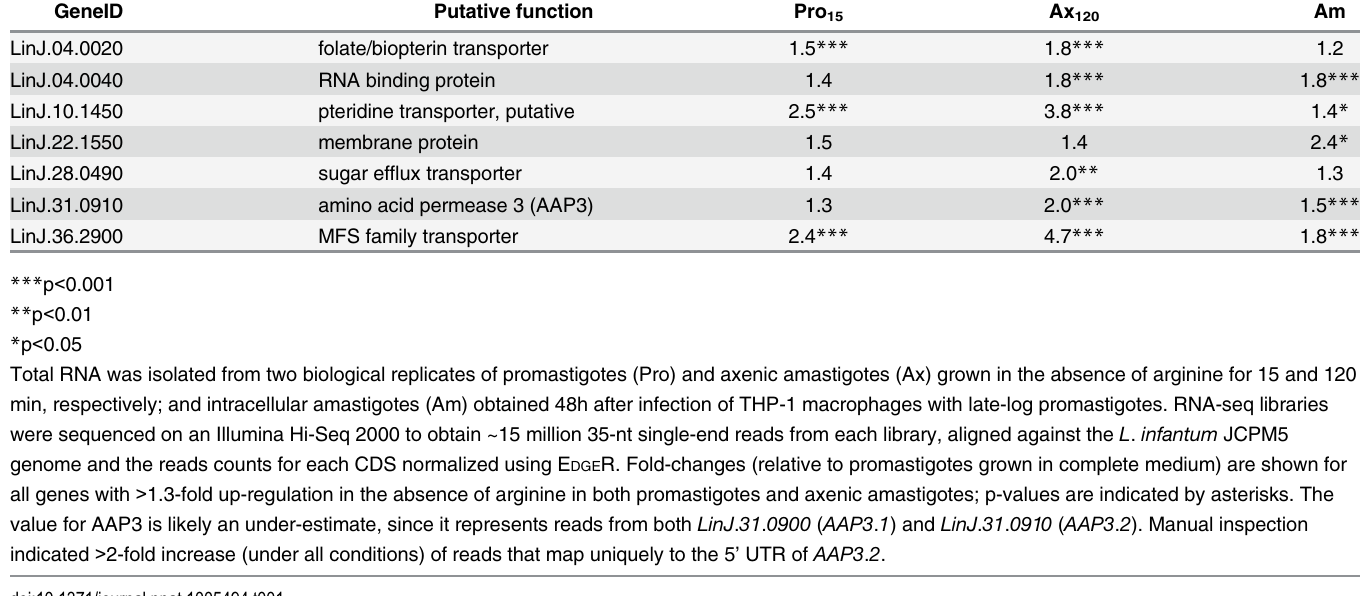
As indicated above, Leishmania cells sense changes in the external arginine concentration. To induce an intracellular response, the sensor likely activates a signaling pathway that results in increased LdAAP3 expression and activity. To elucidate phosphoproteins involved in this path- way, we used the di-methylation tagging technique to examine changes in the phosphorylation profile of promastigotes after 5 and 15 minutes of arginine deprivation. These analyses identi- fied 150 (in 110 proteins) and 122 (in 97 proteins) sites whose phosphorylation changed fol- lowing arginine deprivation at the 5 and 15 minute time-points, respectively (S1 and S2